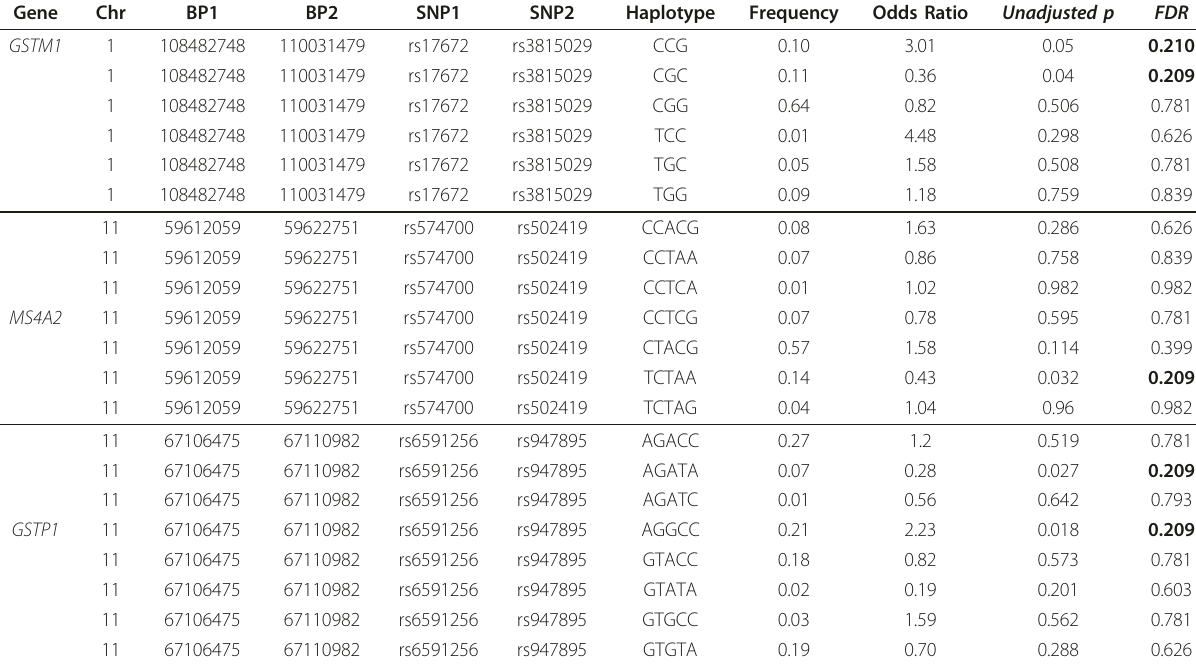
Table 3 Association between haplotypes and asthma